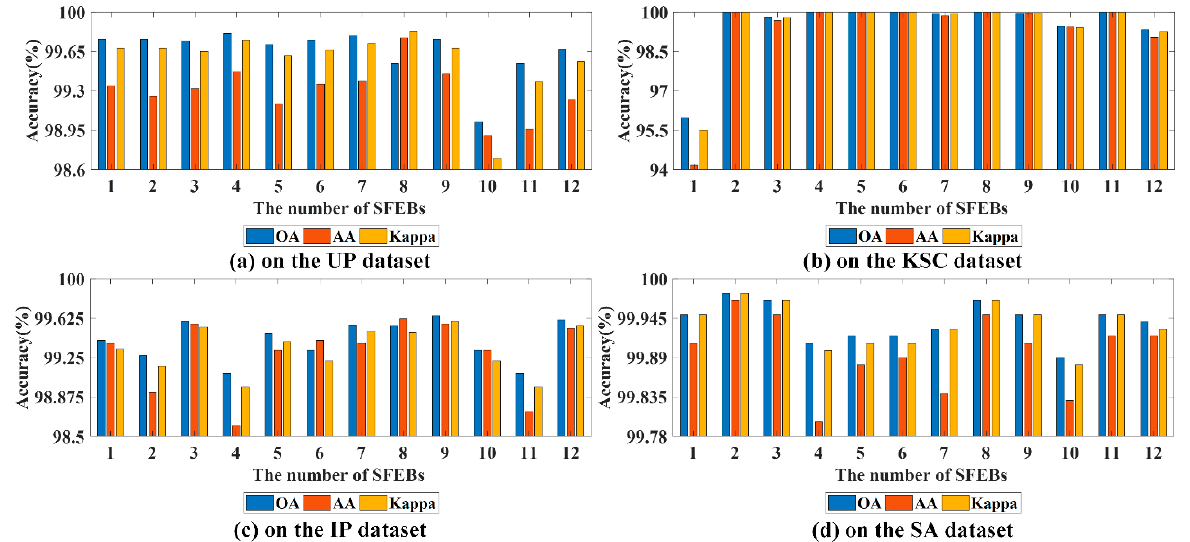
Figure 9. Three evaluation indexes for various numbers of SFEBs on four experimental